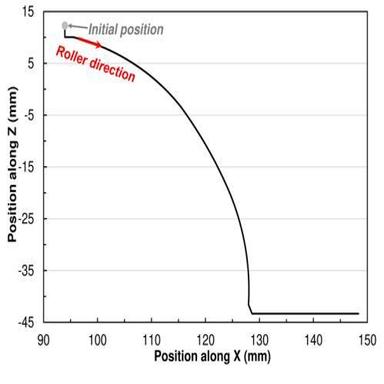
Roller path in the (X, Z) plane.